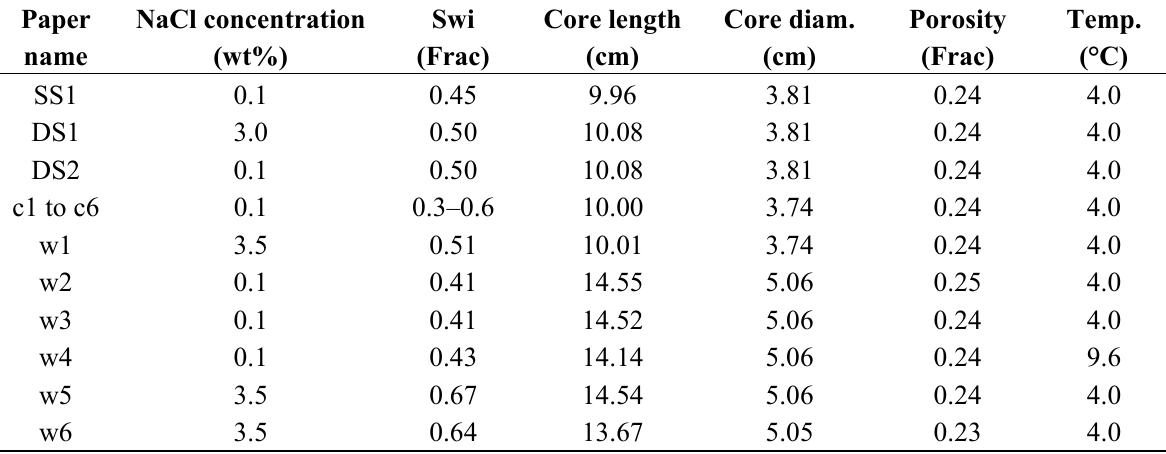
Table 1. Summary of core dimensions, initial saturation and temperature during exchange for samples used in this